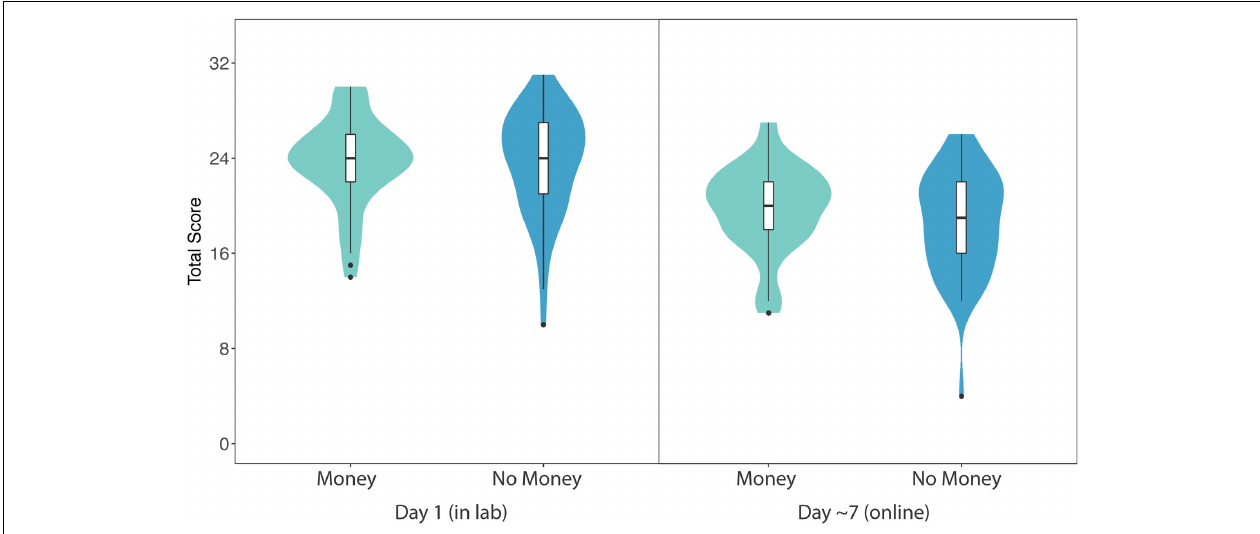
FIGURE 2 | Violin plots showing probability density of total score data for Monetary and No Incentive conditions in Experiment 1 (in lab and online follow-up). Maximum score was 32 points (8 questions per video). Horizontal lines show median average score, surrounded by boxes indicating the interquartile range. Results revealed no significant effect of condition (Monetary vs. No Incentive) on total score in the lab experiment or the online